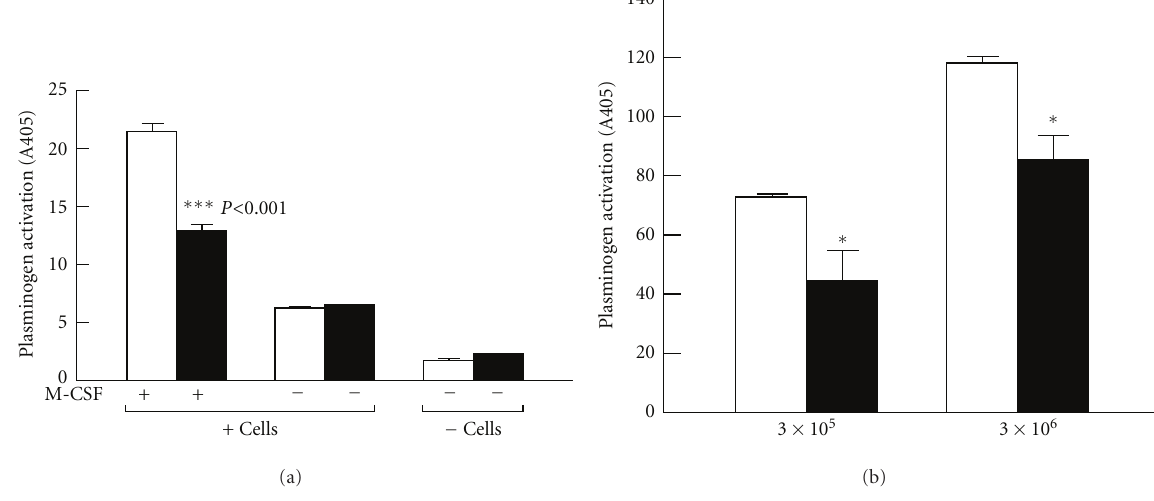
Figure 6: (a) Plg-R KT regulates cell surface plasminogen activation by t-PA. Plasminogen activation was determined after adding 2.7 μ M Glu- plasminogen and 20 nM single chain recombinant t-PA in either the presence or absence of either undi ff erentiated Hoxa9-ER4 progenitor cells or M-CSF-di ff erentiated Hoxa9-ER4 cells and in the presence of either rat anti-Plg-R KT mAb35B10 (filled bars) or isotype control rat IgG2a (open bars). ∗∗∗ P < 0 . 001, compared to the corresponding isotype control. This research was originally published in [18]. (b) Plg-R KT regulates cell surface plasminogen activation by uPA. Plasminogen activation was determined in the presence of di ff erent concentrations of U937 cells, as indicated, and in the presence of 2.7 μ M Glu-Plasminogen and 20nM uPA and in the presence of 170 nM of either anti-Plg-R KT mAb7H1 (filled bars) or mouse IgG2a isotype control (open bars). Cell-dependent plasminogen activation on the tripeptide substrate, S2251, is shown after subtracting plasminogen activation in the absence of cells. ∗∗ P < . 001 compared with the corresponding isotype control. This research was originally published in [20].